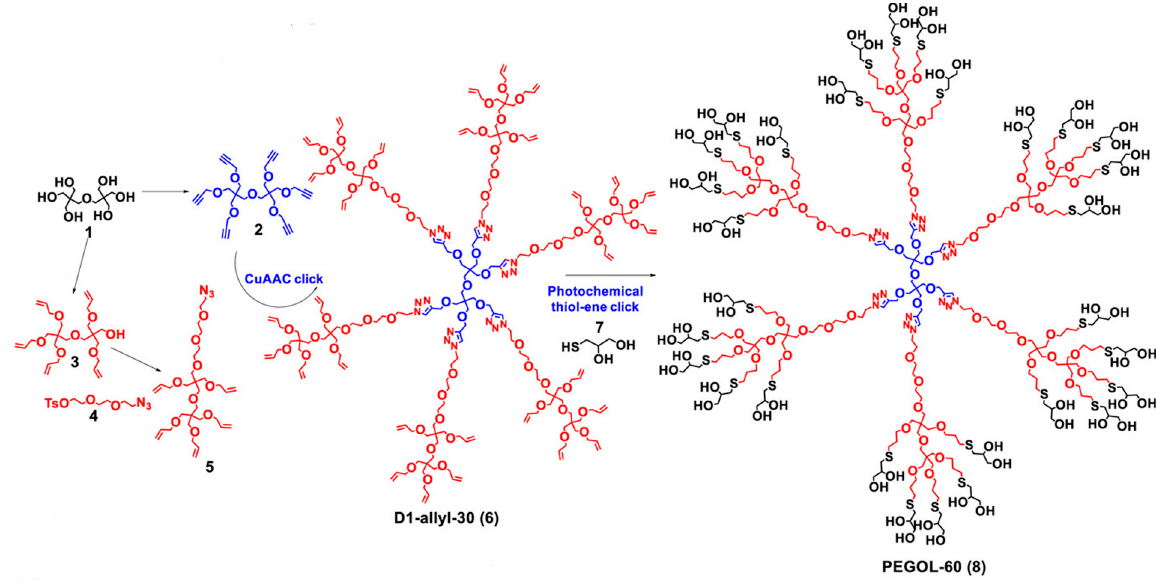
Figure 7. Synthetic route of polyethylene glycol–based dendrimer (PEGOL-60). Adapted from Sharma et al. [178] (licensed under CC BY 4.0).